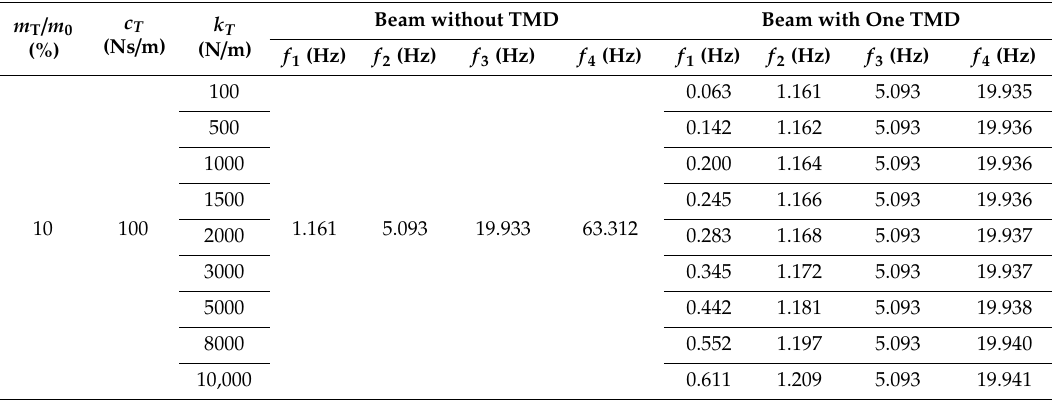
Table 3. Variation of the first natural frequencies as a function of k